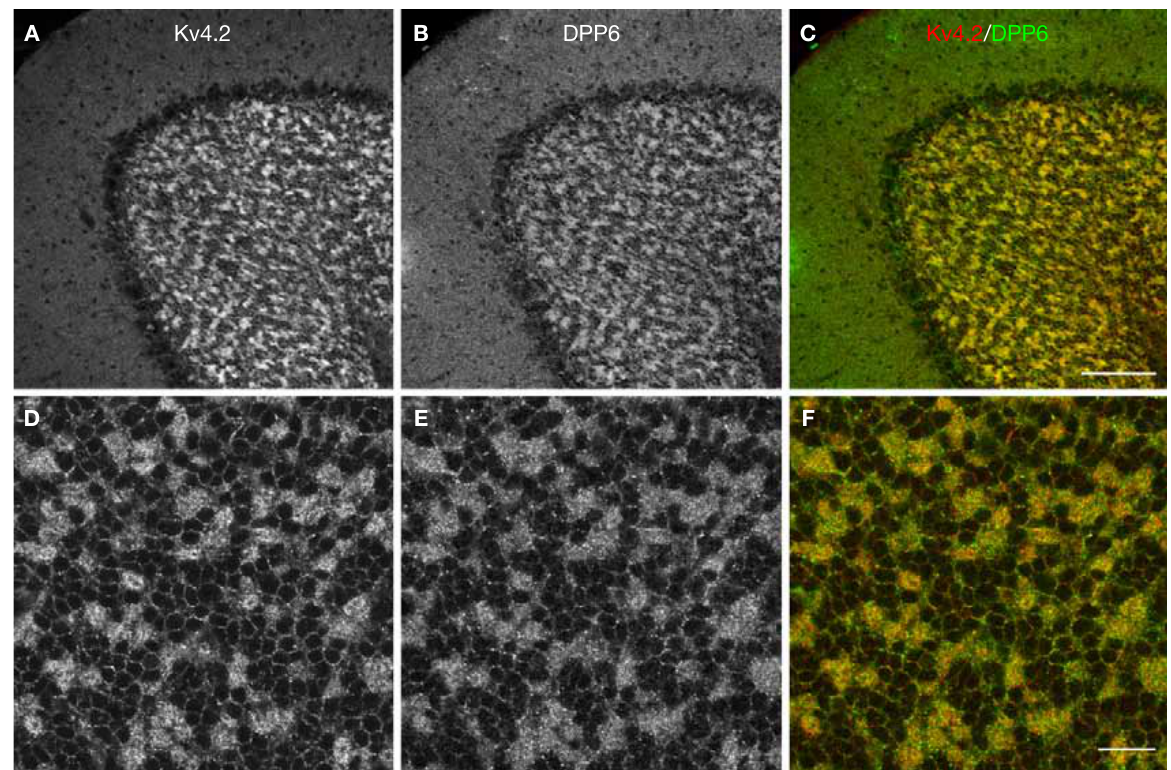
Figure 8 | Double-labeling of Cerebellum with Kv4.2 and DPP6 antibodies. Low magnifi cation of cerebellum showing confocal immumofl uorescence staining of Kv4.2 (A) , DPP6 (B) , and the overlay of the two images (C) . (D–F) High magnifi cation confocal images of granule cell layer double-labeled with Kv4.2 (D) and DPP6 (E) antibodies showing colocalization in cerebellar granule cells. Scale bar: 100 μ m in upper panels; 20 μ m in lower panels.